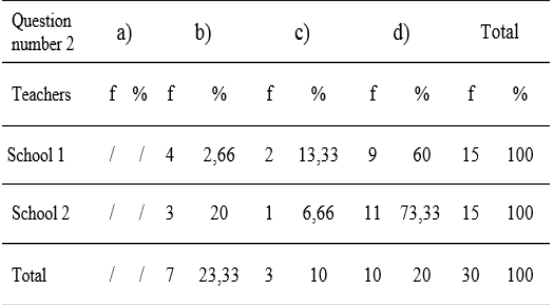
Table 1. «Way of acquiring